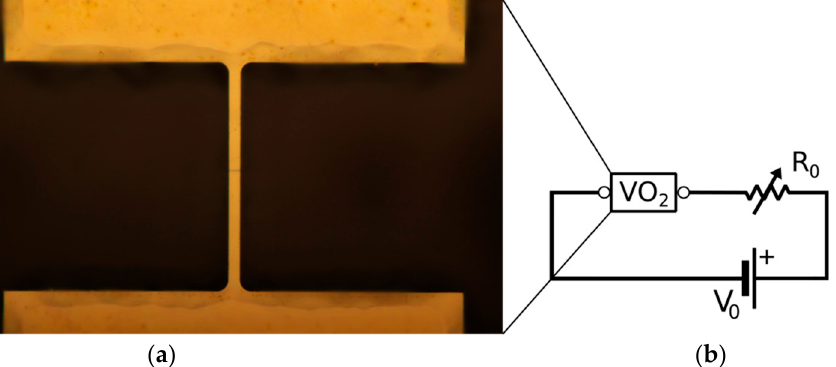
Figure 1. Actuation circuit and microbridge device. ( a ) Optical microscope image showing one prototypical microbridge actuated by biasing a VO 2 region (light strip in the middle) with Au gates (yellow areas); ( b ) Schematic diagram of the electrical circuit used to trigger the electrical oscillations in the VO 2 . R 0 is a variable resistor and V 0 a tuneable voltage source (1–2 V). See also reference